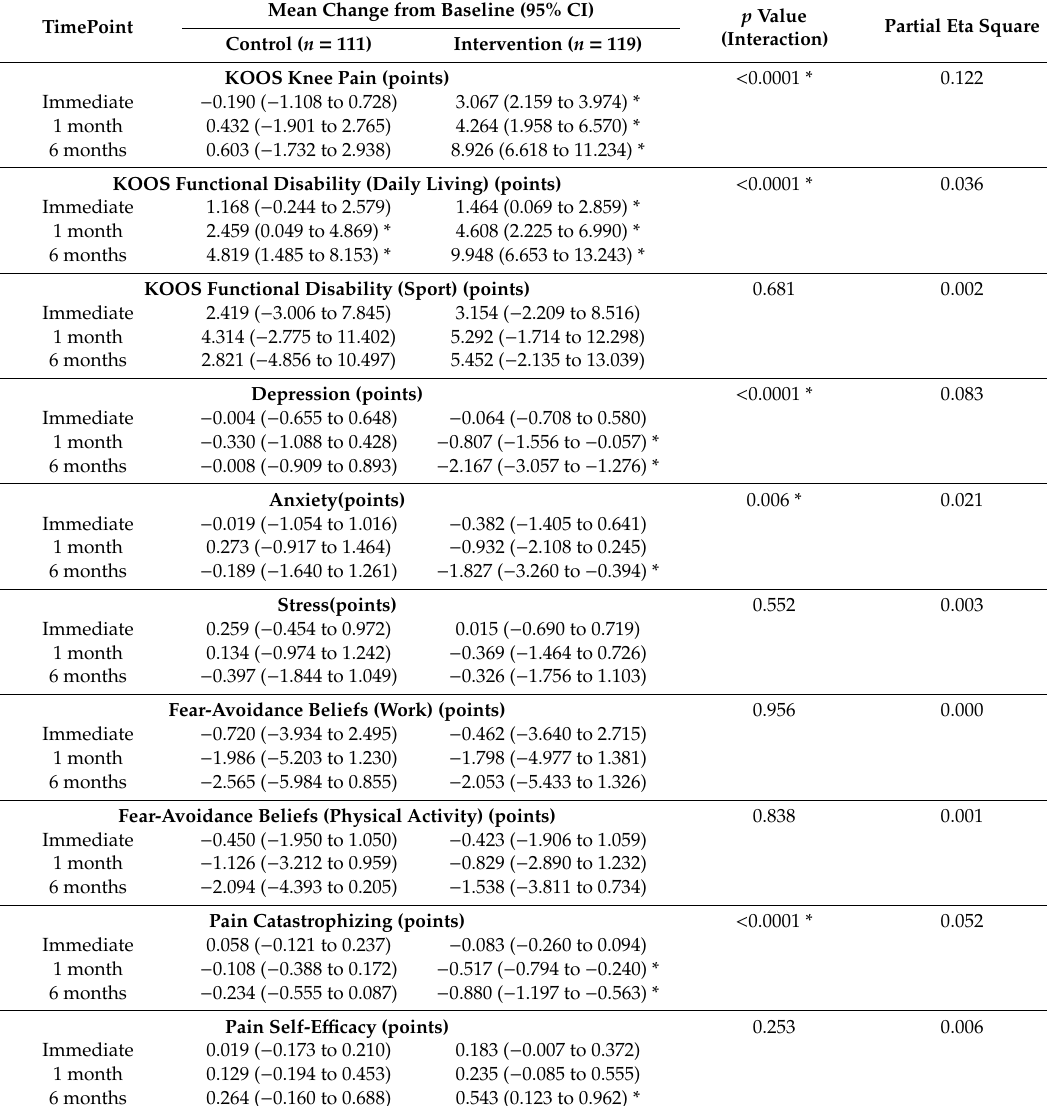
Table 1. E ff ectiveness at immediate, 1 and 6 months post